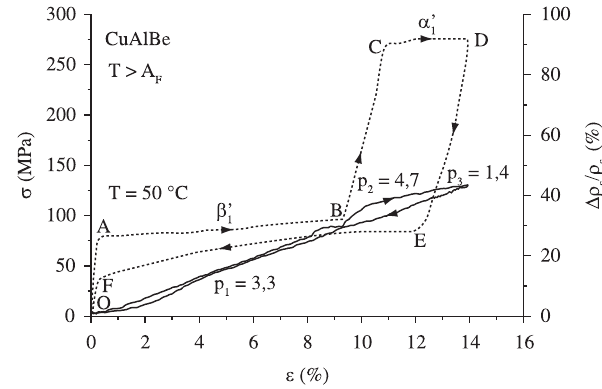
Figure 4. Electro-mechanical curves of successive martensitic transformation in the CAB5